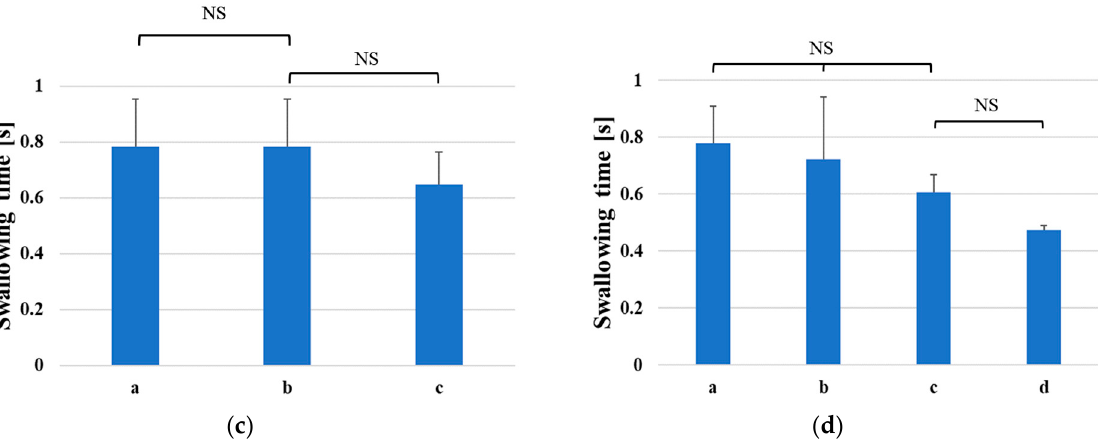
Figure 12. Significant differences in swallowing times between male subjects: ( a ) 30s; ( b ) 40s; ( c ) 50s; ( d ) 60s.